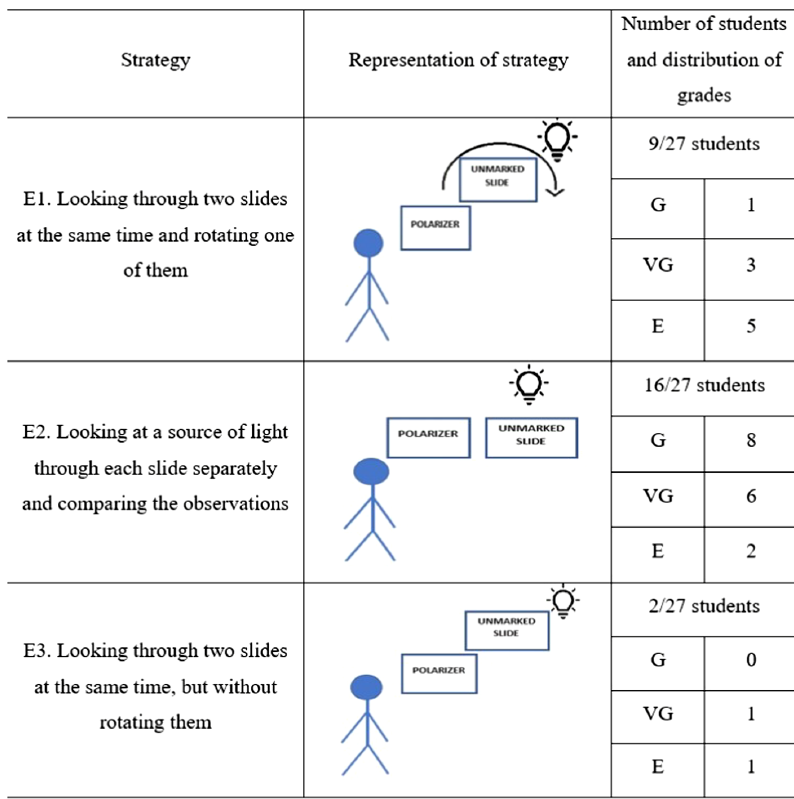
FIG. 4. The list and schematic representation of strategies that students used to determine whether the unknown slide was a polarizer and the distribution of students ’ grades for each